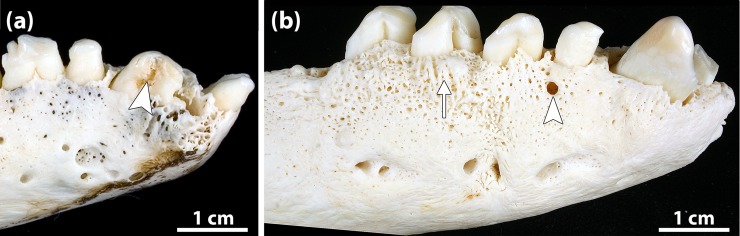
Examples of tooth fracture and sign of periapical lesion in Eastern Atlantic harbor seals (Phoca vitulina vitulina).(a) Fractured right mandibular canine of a 22-year-old female (specimen ZIK 28104). This is a case of complicated crown fracture as the pulp cavity has been opened (arrowhead). The right I2 had been lost intravitally. Also note signs of advanced periodontitis (porosity of alveolar bone due to numerous vascular foramina, and horizontal and vertical loss of alveolar bone) and pronounced signs of wear on the teeth. (b) Right mandible of a 23-year-old male (specimen ZIK 28745). The alveolar bone shows a focal osteolytic area, diagnosed as the opening of a draining tract for pus discharge. This is considered indicative of a periapical lesion associated with the P1. The alveolar bone shows signs of advanced periodontitis in the form of porosity of the alveolar bone (denoting increased vascularity), alveolar exostosis (arrow), and loss of alveolar bone. Note also pronounced wear signs on the teeth.